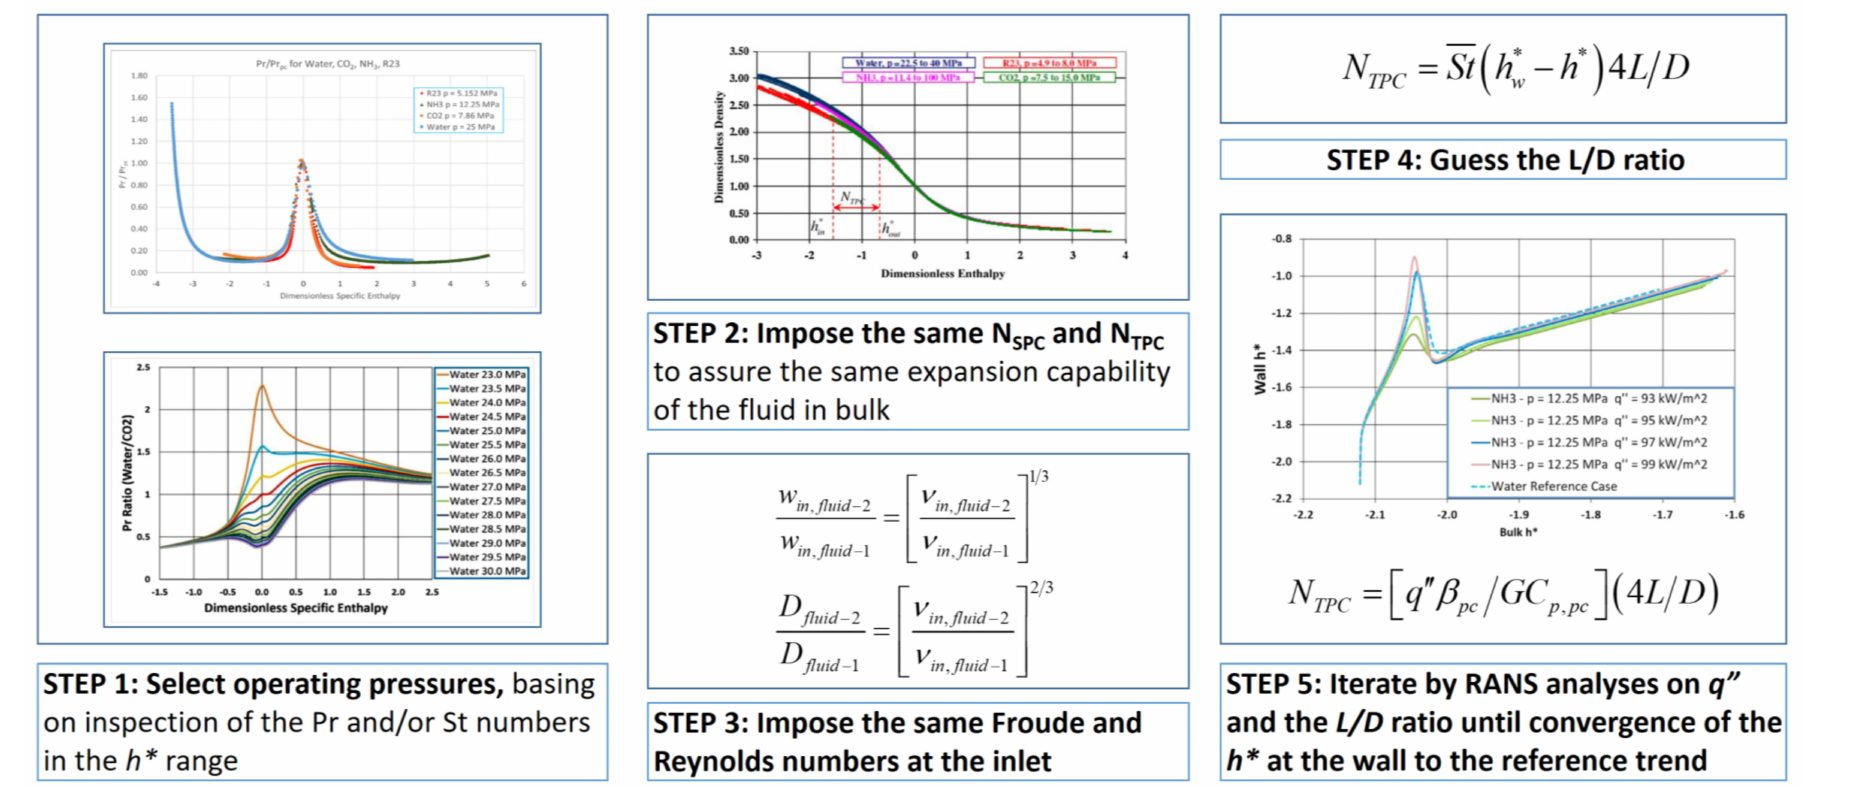
Figure 5. Steps in the rationale of the similarity